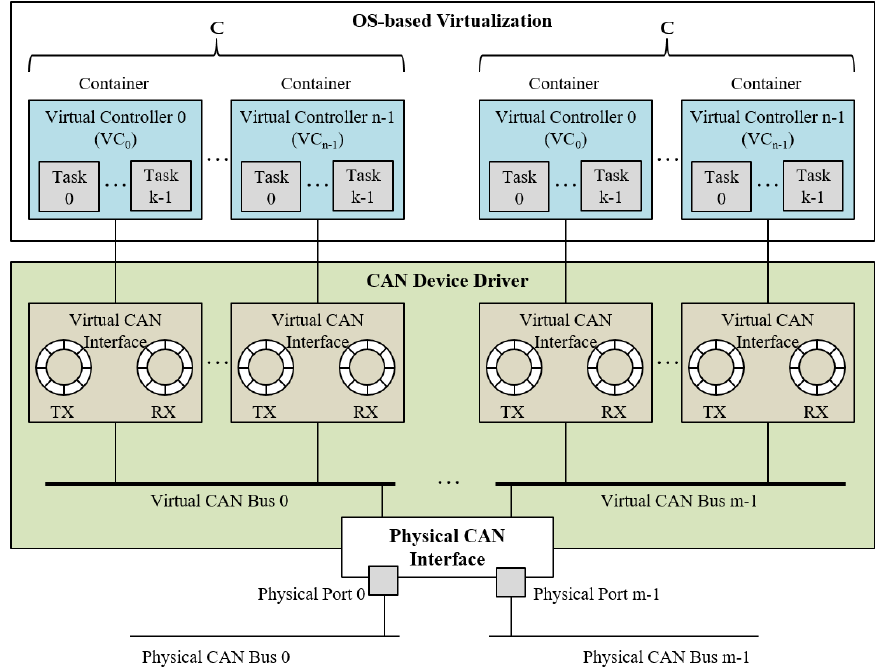
Figure 4. Driver-level Controller Area Network (CAN)